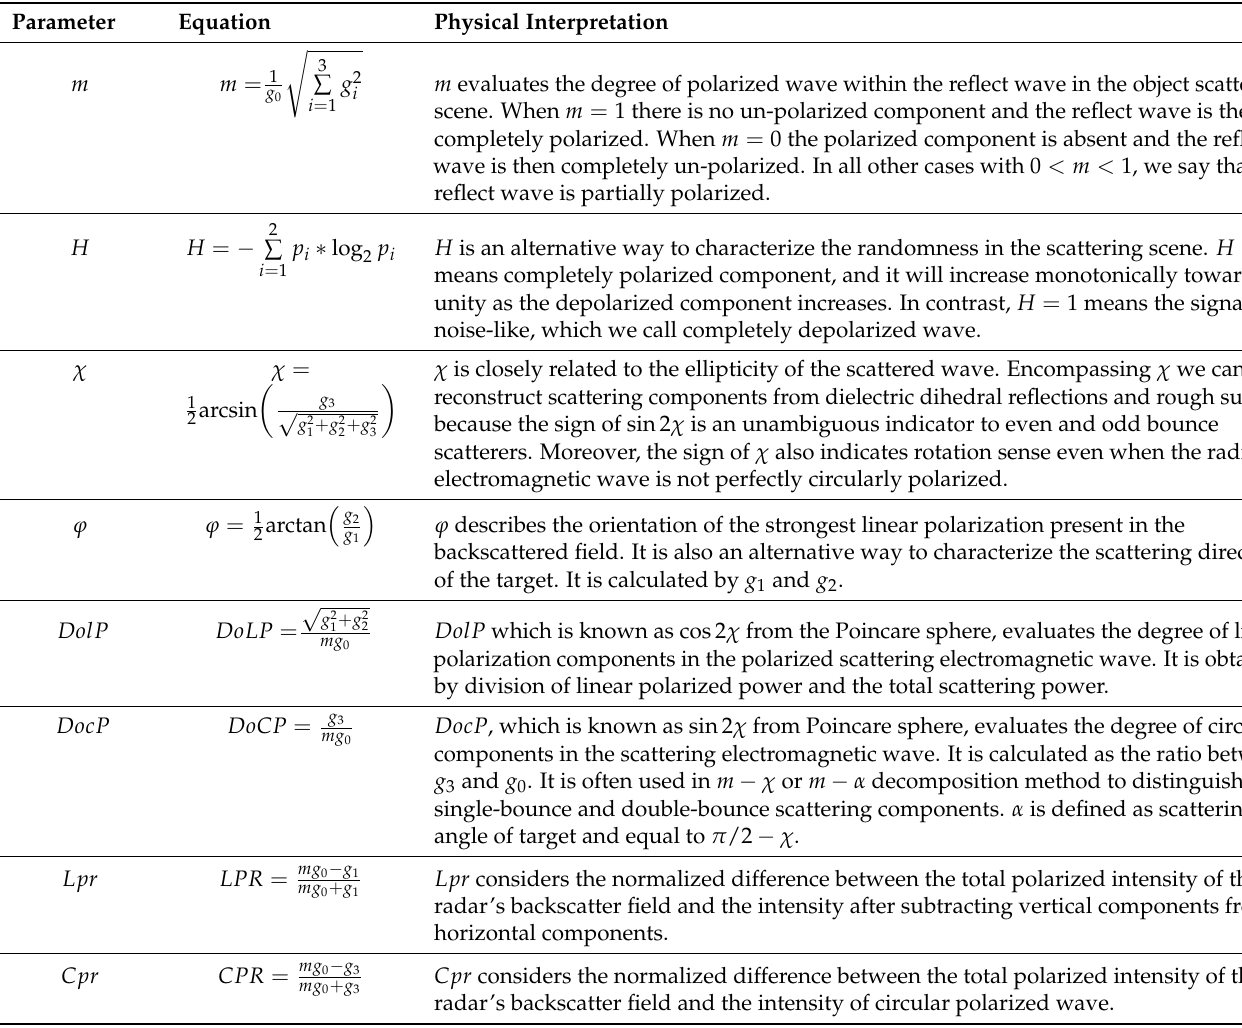
Table 1. The equation and physical interpretation of each Stokes-related